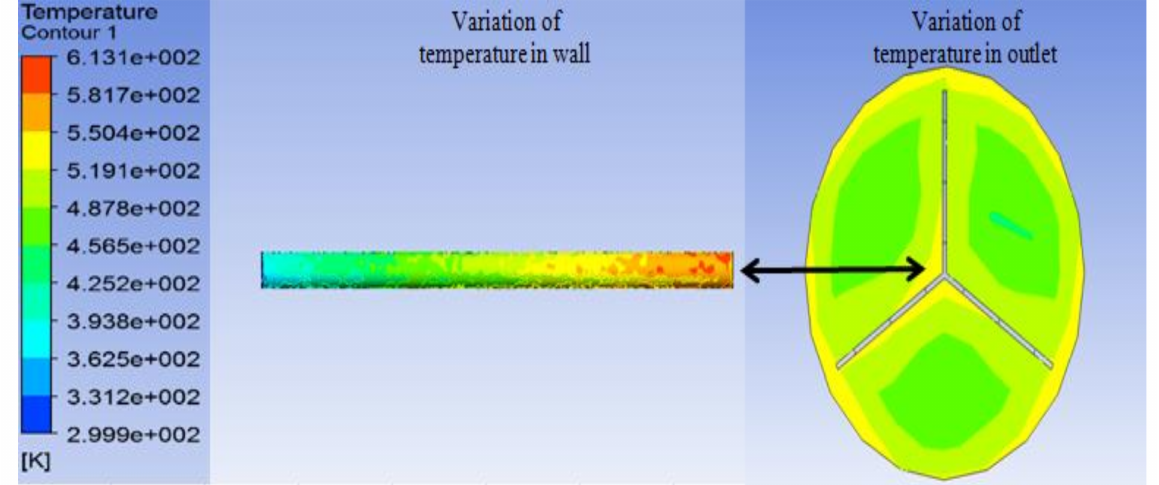
Figure 6. Temperature contours at wall and